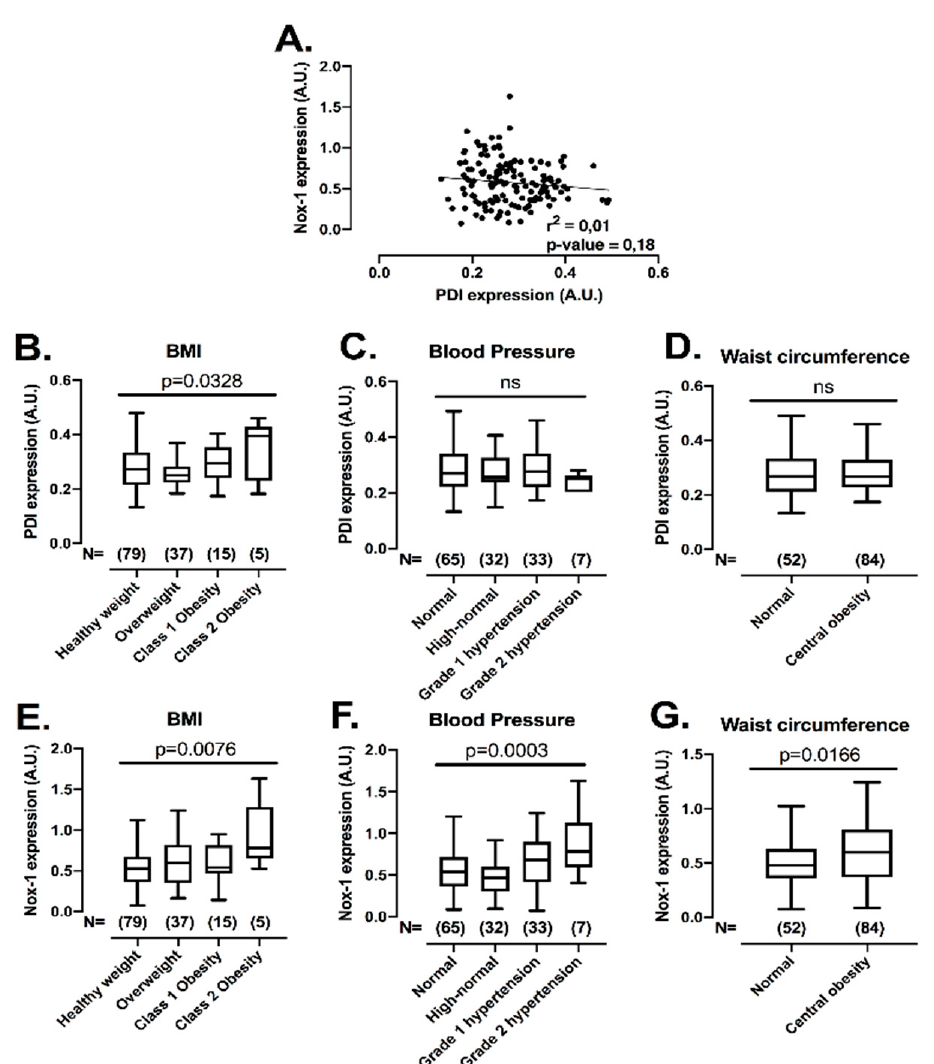
Figure 6. Platelet PDI and Nox-1 levels are independent of one another and upregulated in condi- tions of increased cardiovascular risk. Washed platelets (WP) from 136 volunteers were lysed and immunoblots performed for PDI, Nox-1 and loading control GAPDH. Anthropometric and metabolic characteristics were also collected. Value cut-offs of stratifications can be found on Methods and were all performed according to international guidelines. ( A ) Linear regression of platelet PDI and Nox-1 protein levels. ( B – G ) PDI and Nox-1 expression were stratified by: BMI ( B , E ) in healthy weight (18.5–24.9 kg/m 2 ), overweight (25–29 kg/m 2 ), class 1 obesity (30–34.9 kg/m 2 ) and class 2 obesity (35–39.9 kg/m 2 ); blood pressure ( C , F ) in normal (<120/80 mmHg), elevated (120–129/80 mmHg), high blood pressure (HBP) stage 1 (130–139/80–89 mmHg), HBP stage 2 (140/90 or above mmHg); waist circumference ( D , G ) in normal (Caucasian men < 94 cm; men of other ethnicities < 90 cm; women < 80 cm) and central obesity (Caucasian men ≥ 94 cm; men of other ethnicities ≥ 90 cm; women ≥ 80 cm). Data in graph show box and whiskers depicting median, range and 25th and 75th percentiles analysed by one-way ANOVA and Tukey’s post-test. Overall p -value of one-way ANOVA is shown. ns: non-significant.